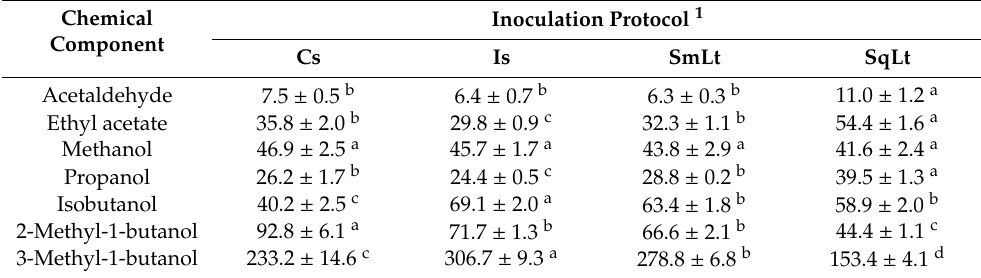
Table 3. Major volatiles (mg/L) of wines produced from pasteurized grape must (mean ± SD, n = 3). Values with different superscript letters within each row differ significantly ( p < 0.05).